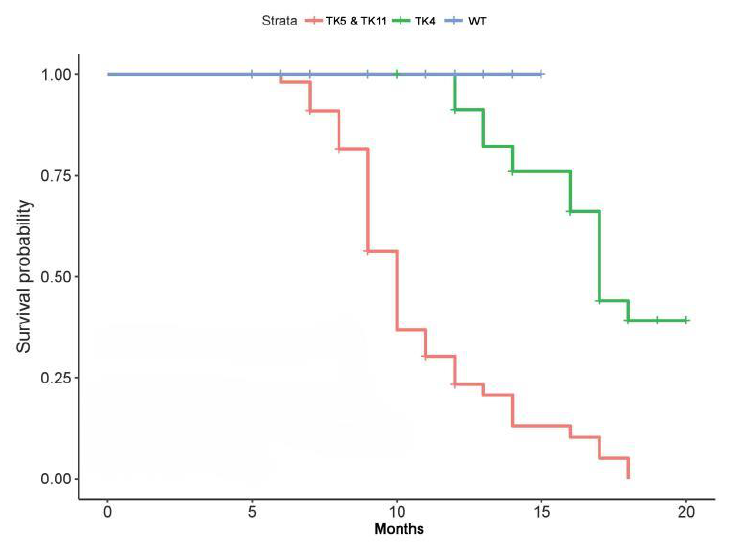
Figure 3. Analysis of onset of HCC development in three lines of HSV-tk transgenic mice. Kaplan-Meier plots showing the survival probability over time (months) of the three lines of HSV-tk mice. Thus, the survival signature was validated for discriminating between lines TK4, TK5, and TK11, as it was showing significant differences in survival time.